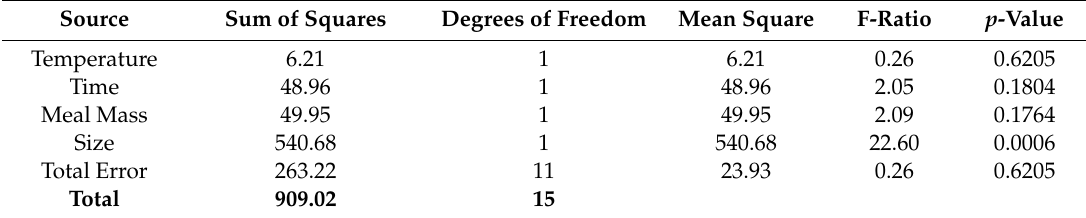
Table 2. Screening experiment analysis of variance (ANOVA)